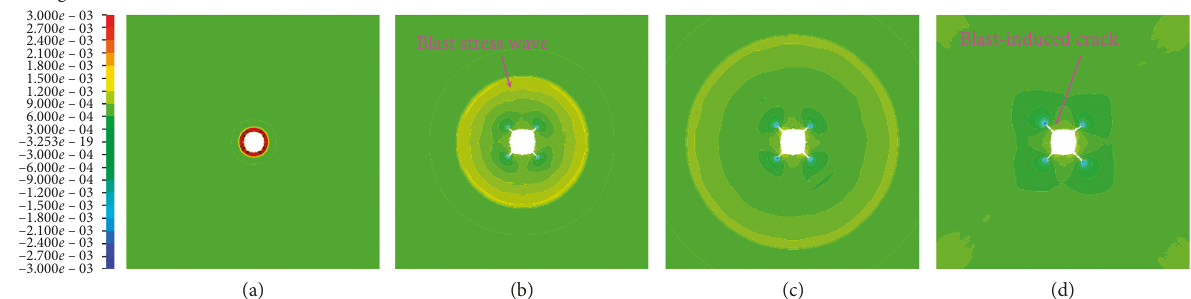
Figure 9: Diagram of blast-induced crack propagation and stress wave transmission of #1 simulation case: (a) t � 20 μ s, (b) t � 120 μ s, (c) t � 240 μ s, and (d) t � 460 μ s.